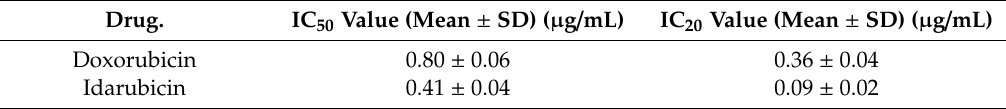
Figure 8. Effects of phytol and lupeol on cytotoxicity, WT1 expression, and total cell number of K562 cells. ( A ) K562 cells at a density of 1.0 × 10 5 cells/mL treated with various concentrations of phytol and lupeol for 48 h. Cell viability was determined using MTT assay. Each point represents mean ± SD of three independent experiments performed in triplicate. ( B ) The cells at a density of 1.0 × 10 5 cells/mL grown in a medium with 40 and 21 µg/mL of phytol and lupeol, respectively for 48 h in comparison with and F9 (23.3 µg/mL). The vehicle control was 0.08% DMSO in the medium. WT1 and GAPDH Table 2. IC 50 and IC 20 values ( µ g / mL) of doxorubicin and idarubicin in K562 cell line. protein levels were determined using Western blot analysis. The WT1 protein levels were then measured and normalized using the GAPDH protein level. ( C ) Total cell number after treatment with phytol and lupeol determined by trypan blue exclusion method. Data are expressed as mean ± SD of three independent experiments. Asterisk (*) demonstrates statistically significant difference between the values of the vehicle control and the sample ( p < 0.05). Table 2. IC 50 and IC 20 values (µg/mL) of doxorubicin and idarubicin in K562 cell line. Drug.